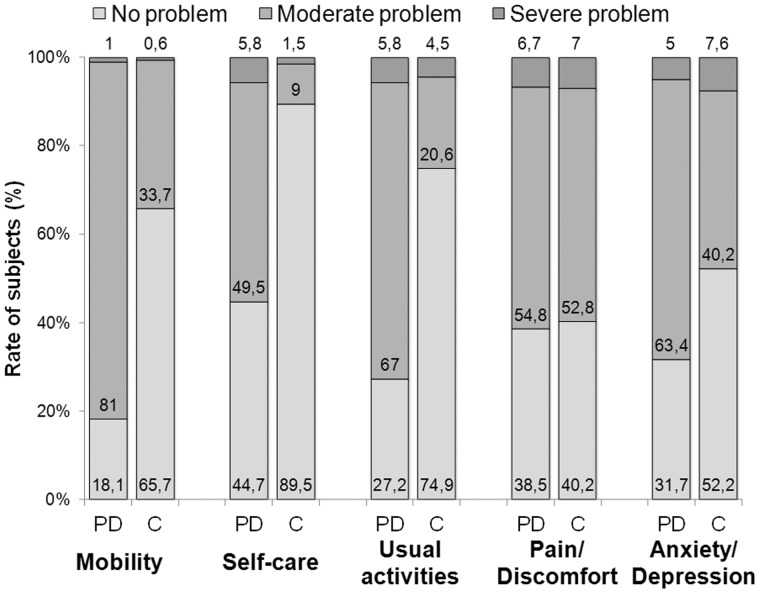
EQ-5D results in Parkinson's disease and the general population in Hungary.Rate of PD patients reporting different levels of problem in the EQ-5D scale, in comparison with the general population in Hungary [11]. PD: Patients with PD, age mean 63.3 (SD: 11.3) years, N = 110; C: control, general population, age-group 60–69 yrs, N = 721.